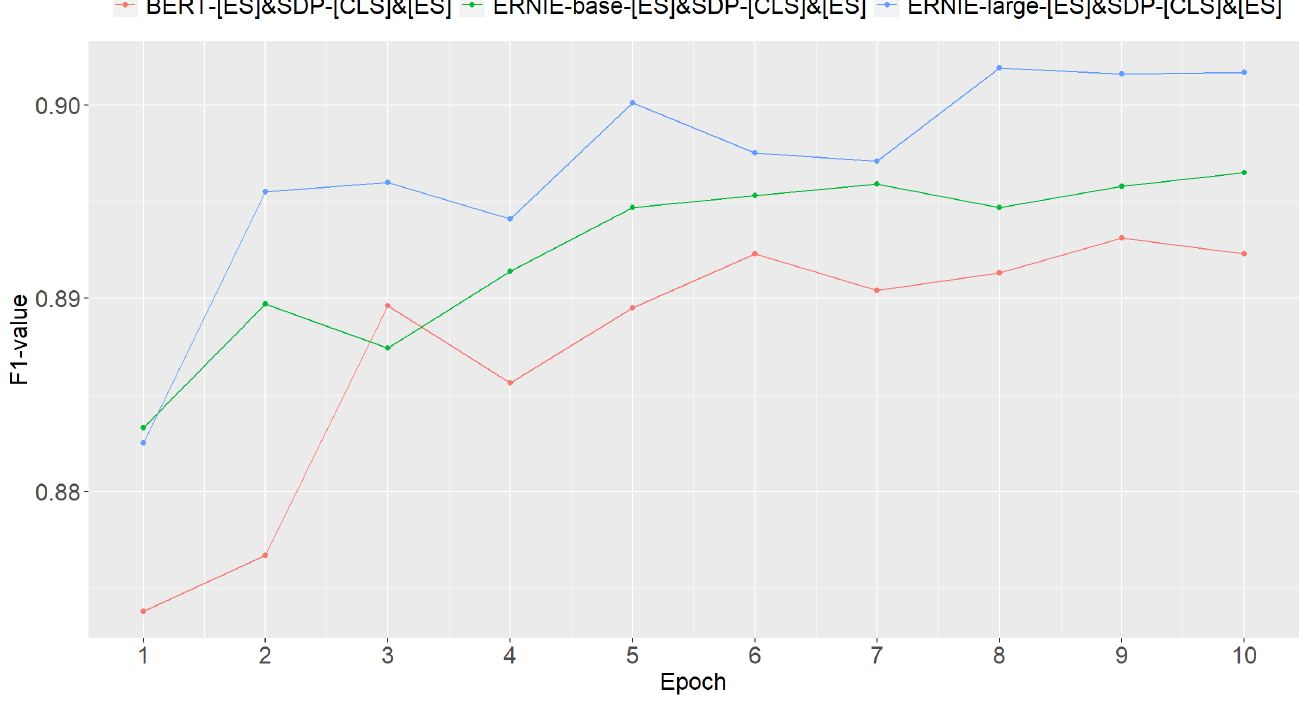
Figure 9. The F1 values using different pre-training models at each training